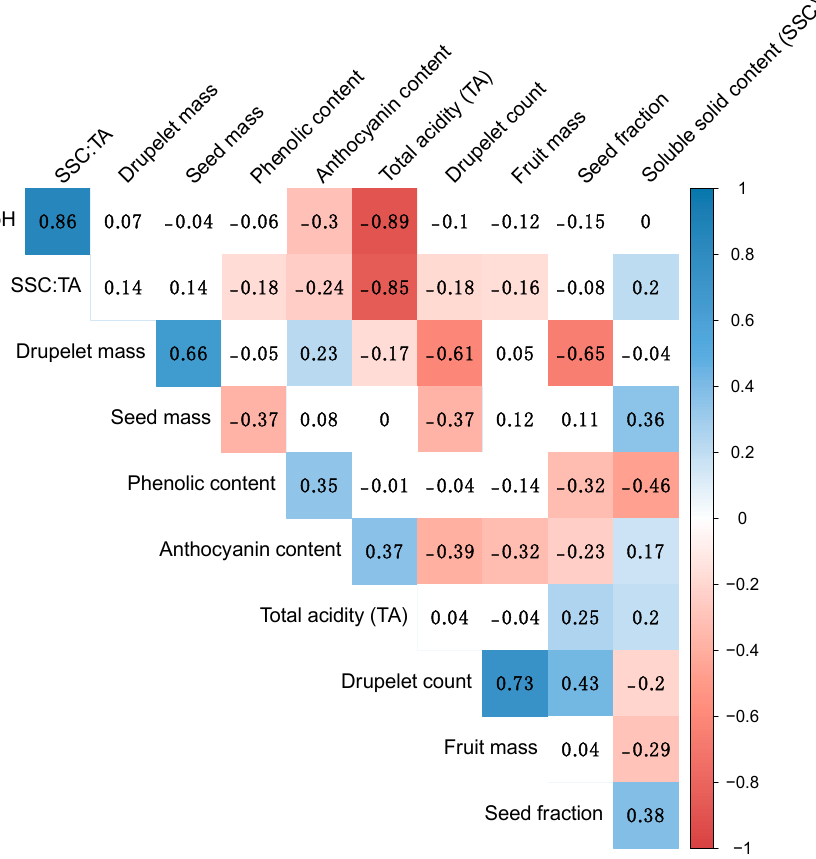
Figure 2. Pearson correlation coefficient plot of breeding values for fruit size and chemistry traits. Significant correlations ( p < 0.01) are shaded in red (negative) or blue (positive).